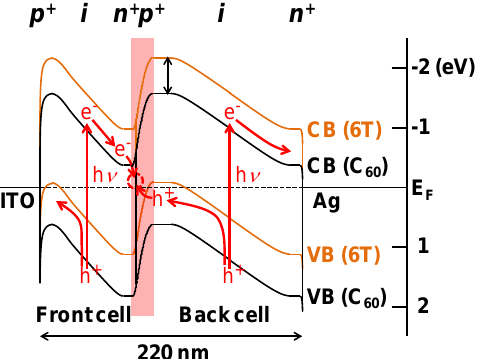
Figure 27. Energy band diagram of the depicted tandem cell based on Kelvin probe measurements (Figure 26). The red shaded region corresponds to the depletion layer for an n + p + -homojunction acting as an ohmic interlayer. VB and CB denote the valence band and the conduction band, respectively. The bands for C and 6T are shown by the black and 60 orange curves,